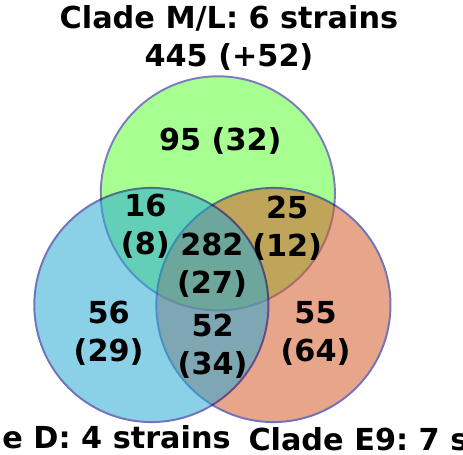
Figure 1. Venn diagram of the numbers of protein families shared between FV clades. For each area of the diagram, the number of protein families ubiquitously conserved in all of the FVs of the corresponding group is indicated. Numbers in brackets indicate additional protein families that were only conserved in a subset of FVs from the relevant group. The names of the FV strains contained in each clade are detailed in Figure 2.